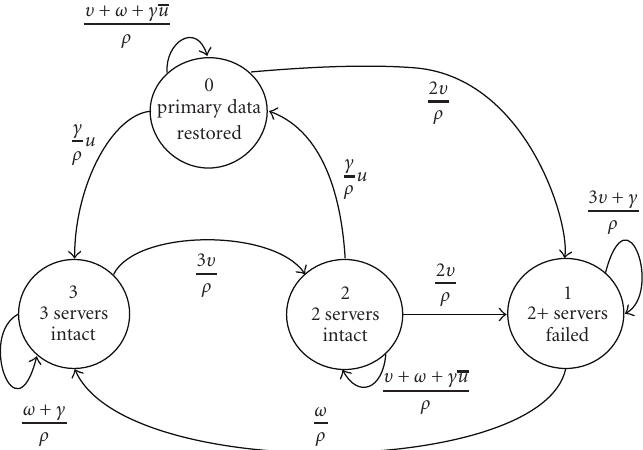
Figure 4: Markov chain model of the database where overhaul does not occur until a second server failure.